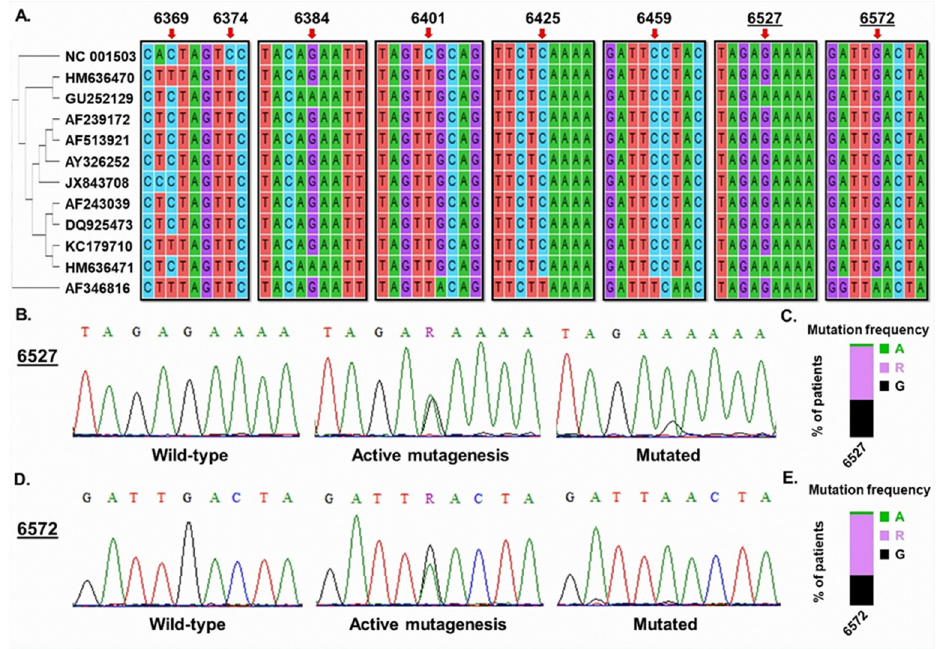
Figure 1. Evidence for APOBEC3-mediated editing in human-derived MMTV sequences. ( A ). APOBEC3 mutation sites in human-derived MMTV-env sequences from NCBI Nucleotide databank. Numbers indicate nucleotide position in the reference MMTV genome (NC_001503). ( B ). Sanger-sequencing chromatograms for nucleotide 6527 of MMTV-like genome representing a wild-type sample ( left ), a sample with ongoing mutagenesis in viral genome ( middle ), and a sample with consolidated mutation ( right ). ( C ). Frequency of patients showing genotypes represented in ( B ). ( D ). Sanger-sequencing chromatograms for nucleotide 6572 of MMTV-like genome representing a wild-type sample ( left ), a sample with ongoing mutagenesis in viral genome ( middle ), and a sample with consolidated mutation ( right ). ( E ). Frequency of patients showing genotypes represented in ( D ). Table 1. Association between APOBEC3A/B genotypes and detection of MMTV-like env gene in BC